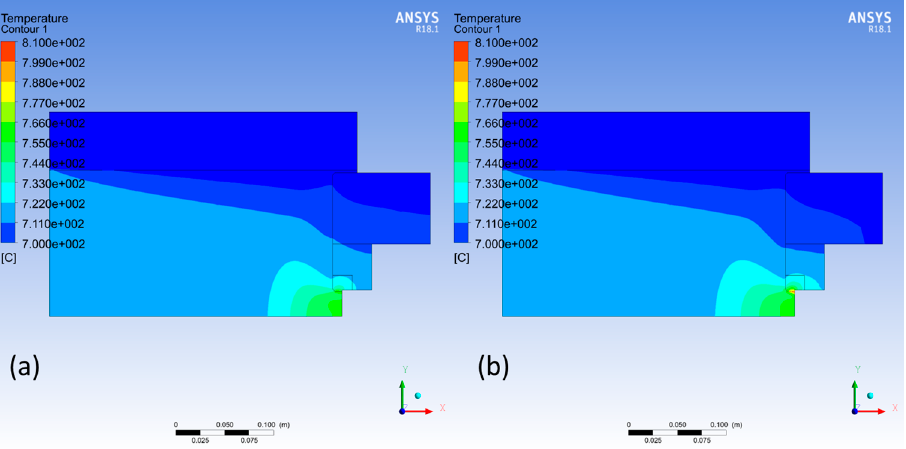
Figure 5. Contours of temperature (values smaller than 700 °C are clipped to the blue color contour). ( a ) Solution with no friction f = 0 Ns/m 3 , S = 1.5 cm/s, f β = 0.5, T in = 715 °C, h = 1.7 W/(m 2 K). ( b ) Solution with friction f = 5 × 10 8 Ns/m 3 , S = 1.5 cm/s, f β = 0.5, T in = 715 °C, h = 1.7 W/(m 2 K). Notice the formation of a small hot spot—due to high friction—near the outlet and on the outer layer of the extruded product.